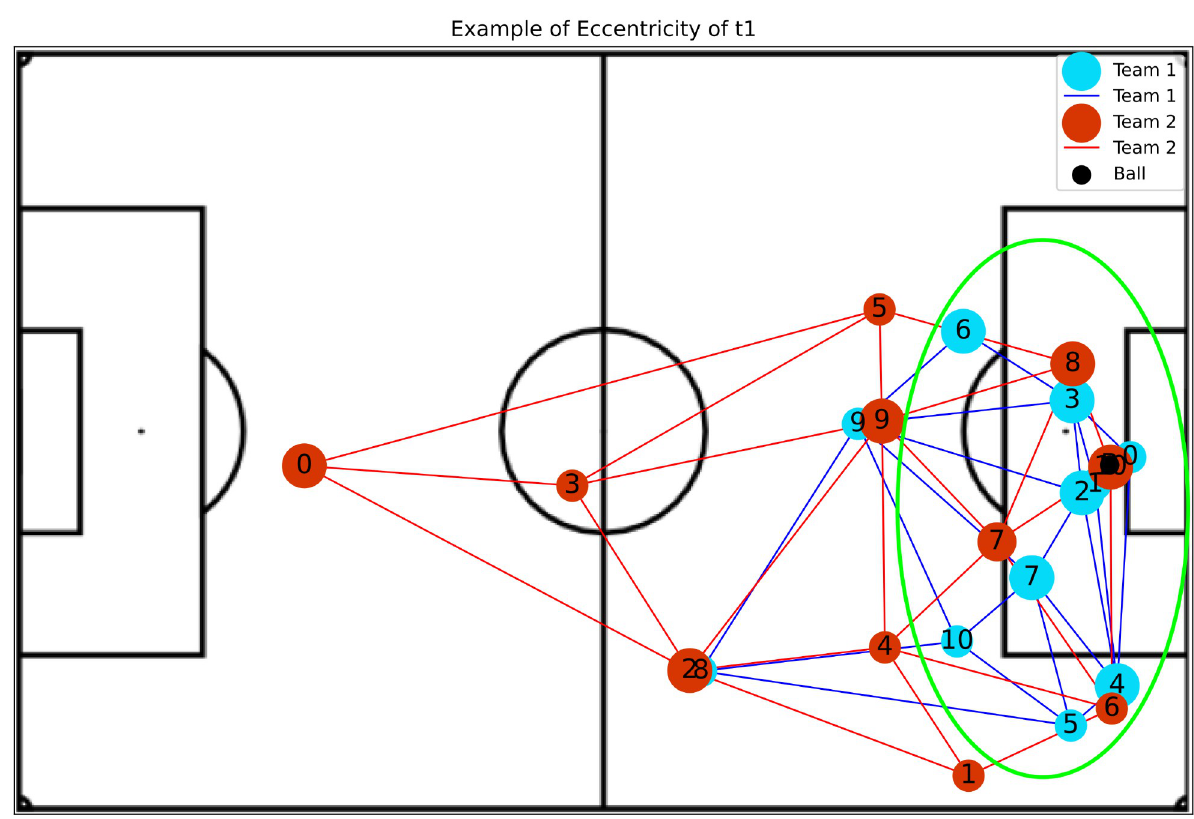
Fig 4. The image shows a situation with a high value of eccentricity of t1 (team with the ball possession). Here, it is possible to observe the players are separated in the highlighted green zone, but with many options to make passes.